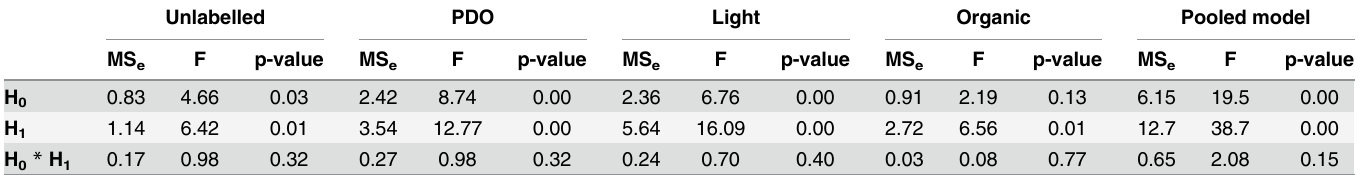
Table 5. ANOVA analysis: testing projection bias across the four cheese products and for pooled data. Unlabelled PDO Light Organic